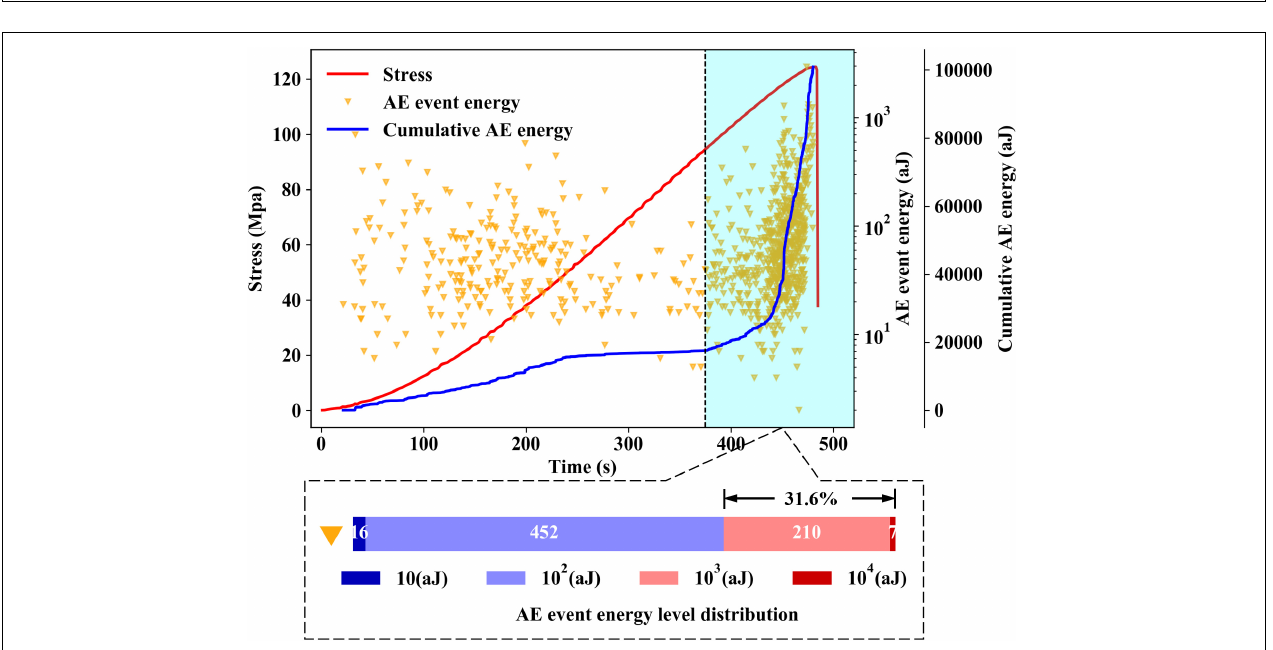
FIGURE 6 | Evolution and distribution of AE events energy versus time in saturated water granite. The crack propagation phase corresponds to the concentrated release of energy (highlighted area), and high energy level acoustic emission events account for 31.6%. AE sources tend to fracture more gently in critical state of rock burst.